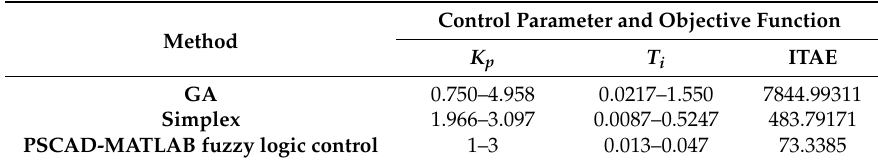
Table 2. Optimal K p and T i ranges found using the GA, simplex method and fuzzy logic control.